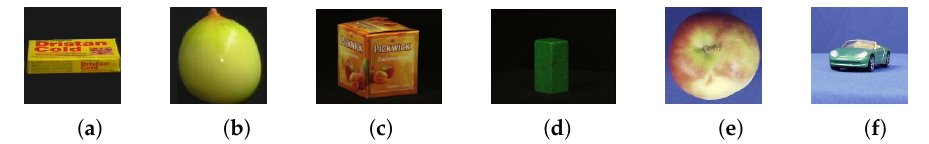
Figure 4. Example images from the Columbia Image Database Library (COIL-100) dataset ( a , b ), the Amsterdam Library Of Images (ALOI) dataset ( c , d ), and the ETH-80 dataset ( e , f ).